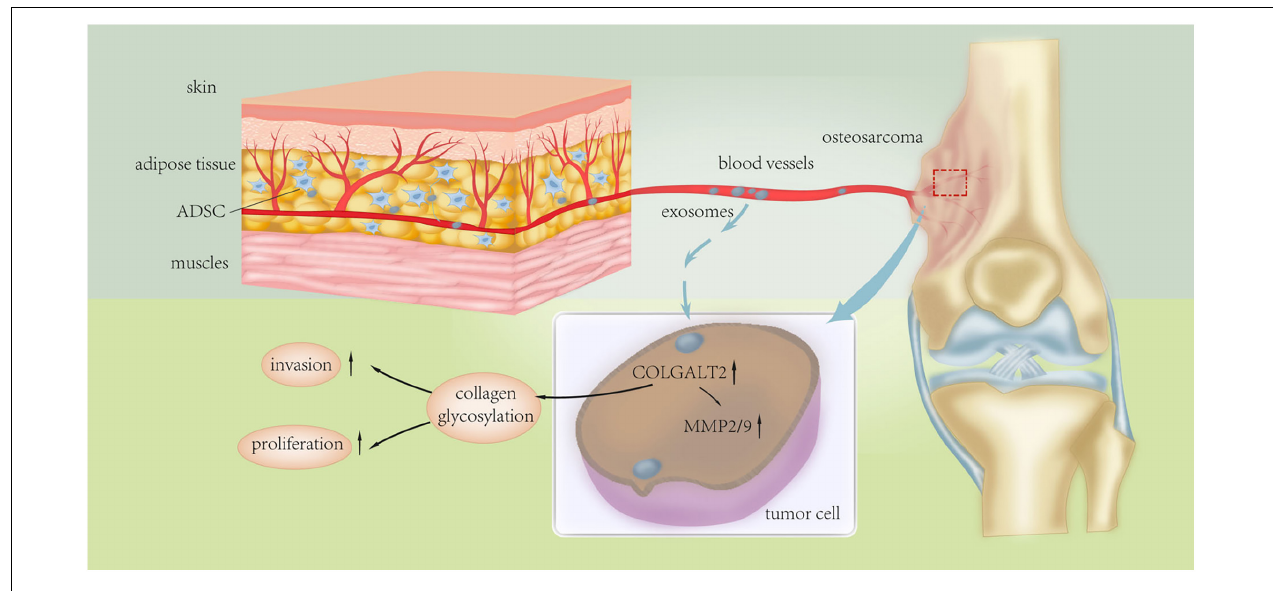
FIGURE 4 | Schematic diagram of the underlying mechanism of ADSC exosomes in osteosarcoma proliferation and metastasis. Adipose tissue-derived mesenchymal stromal cell (ADSC) exosomes induce upregulation of COLGALT2 in osteosarcoma cells, accompanied by increased expression of vimentin and MMP2/9. Reprinted from Wang Y. et al.